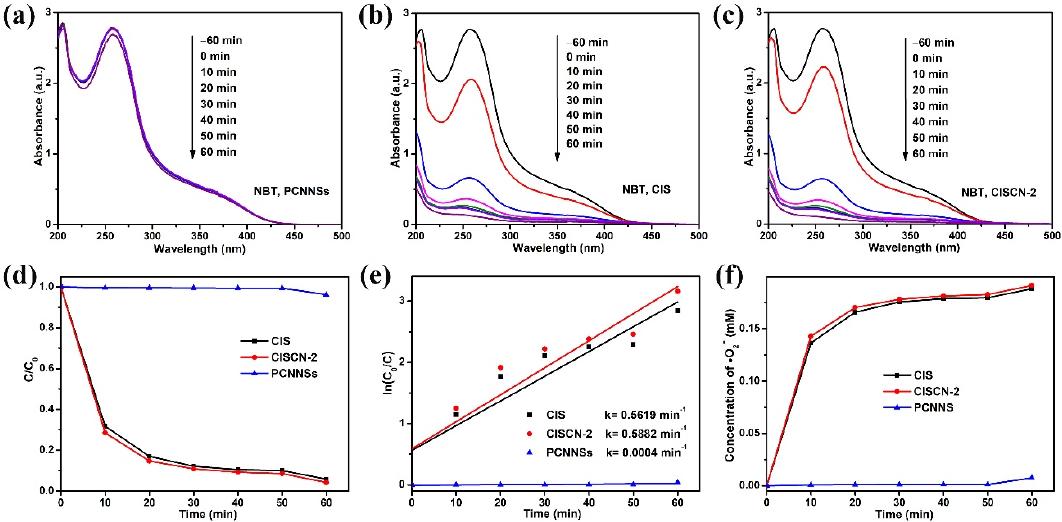
Figure 9. Time courses of absorption variation of NBT over ( a ) PCNNSs, ( b ) CIS, and ( c ) CISCN-2. ( d ) Time-dependent photodegradation plots of NBT over different catalysts; ( e ) the corresponding pseudo-first-order kinetic fitting curves, ( f ) time-dependent concentration curves of •O 2 − .